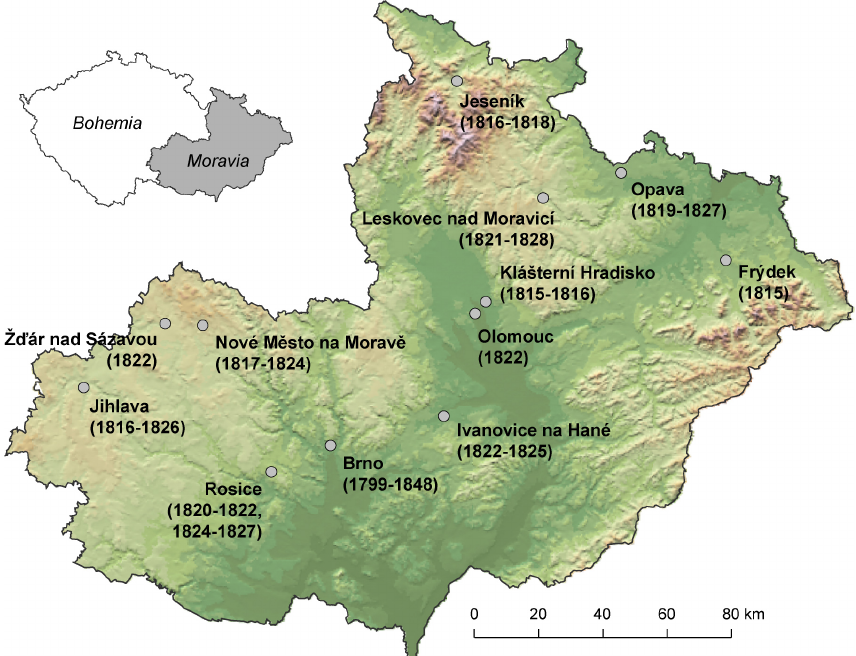
Figure 3. Network of meteorological stations in Moravia and Silesia as organized by the Imperial-Royal Moravian-Silesian Economic Society (years indicate available meteorological observations preserved in